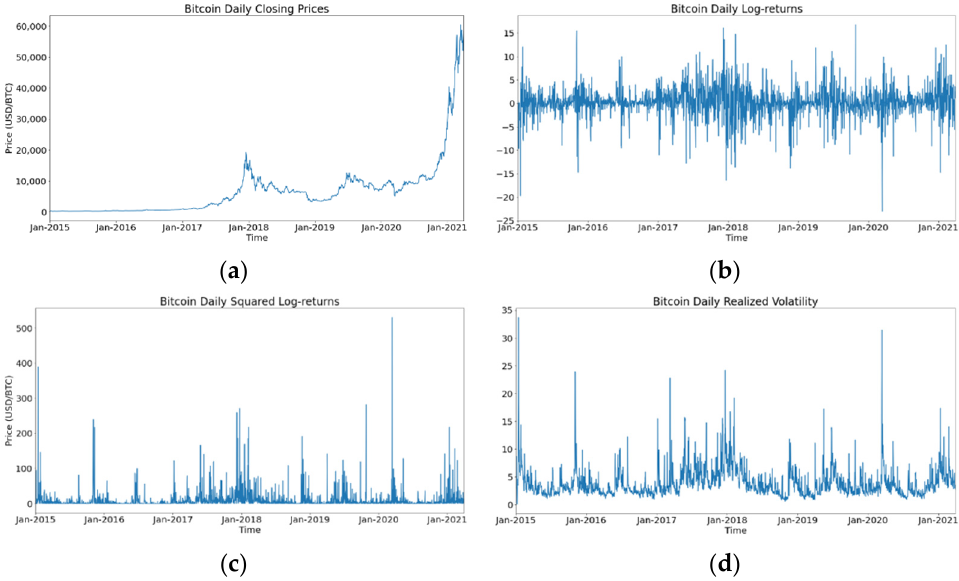
Figure 4. Bitcoin ( a ) daily closing prices, ( b ) log-returns, ( c ) squared log-returns, and ( d ) realized volatility from 1 January 2015 to 31 March 2021. Figure 5 compares Bitcoin’s log-returns with the estimated volatility of GARCH-type models.